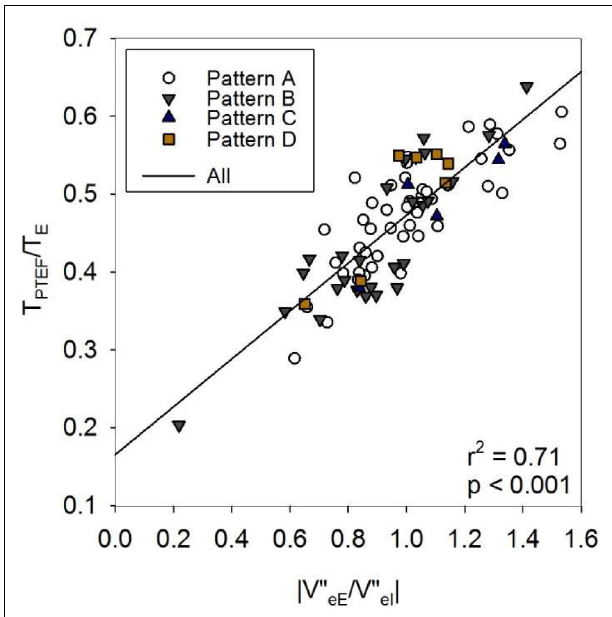
FIGURE 6 | Effect of asymmetry in volume acceleration (V”) ratio on T PTEF /T E . eE: end expiration; eI: end inspiration; T PTEF : time to peak tidal expiratory flow; T E : expiratory time. For definitions of Patterns A–D, see text or the legend to Table 1 .